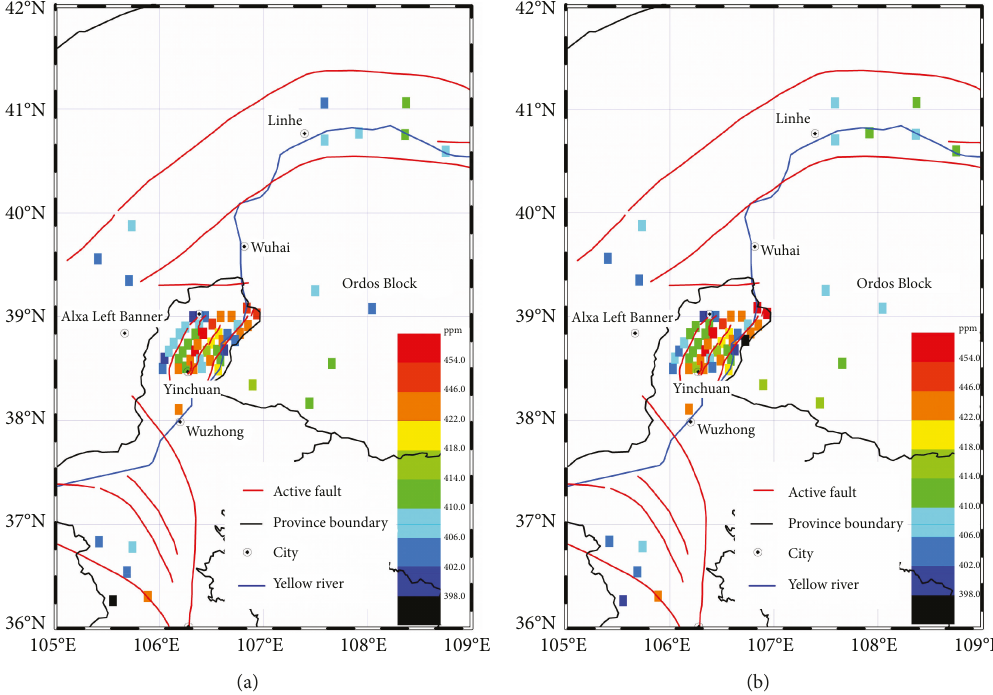
Figure 3: Distributions of CO concentrations at (a) a height of 1.5 m and (b) the surface (0 m), for di ff erent tectonic settings along the 2 western margin of the Ordos